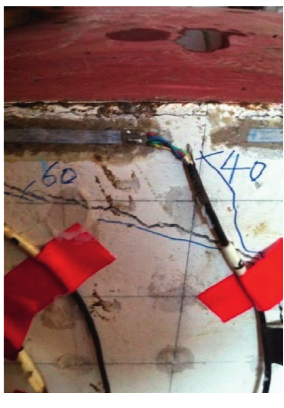
Figure 11: Inclined crack.